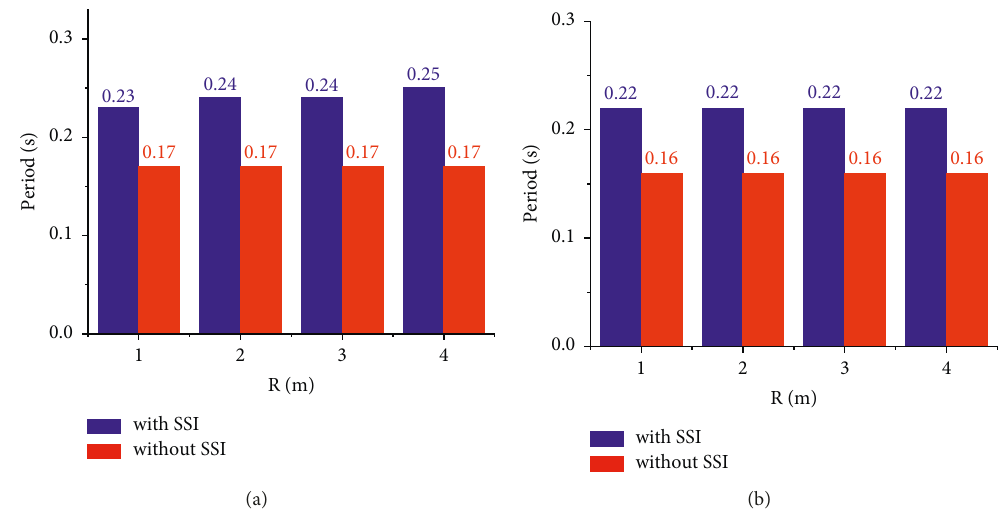
Figure 7: Periods of modes 5 to 6 under different radii of FRS. (a) Mode 5. (b) Mode